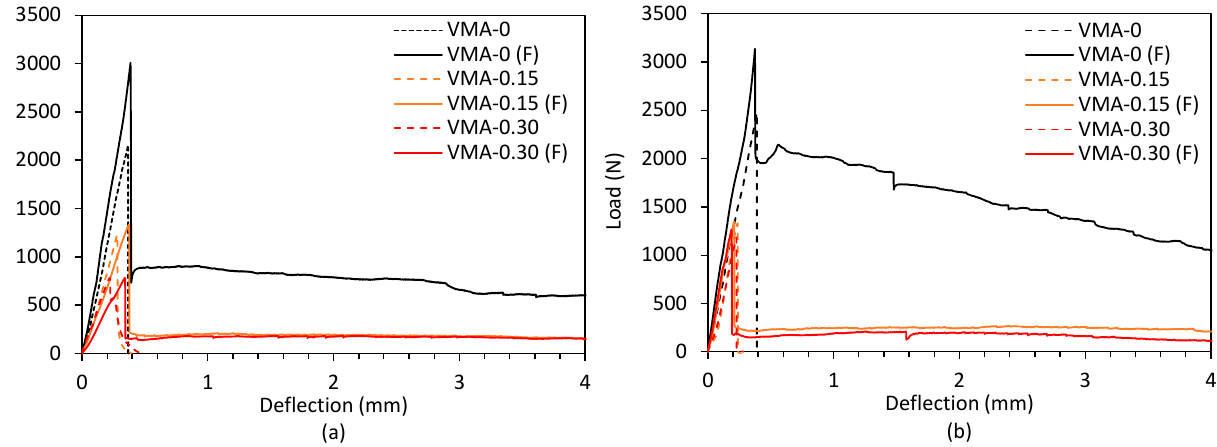
Figure 13. Load–deflection curves of the extruded specimens after 7 ( a ) and 28 ( b ) days of curing.